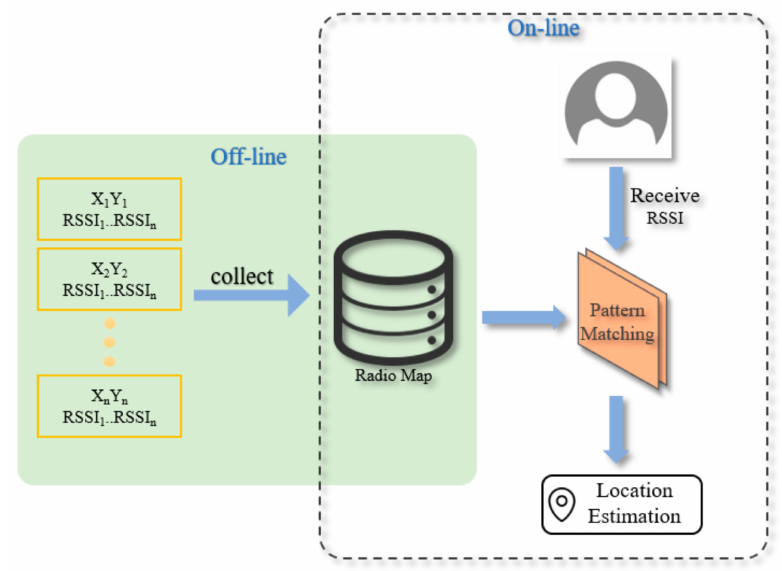
Figure 1. RADAR Positioning Technology Flowchart